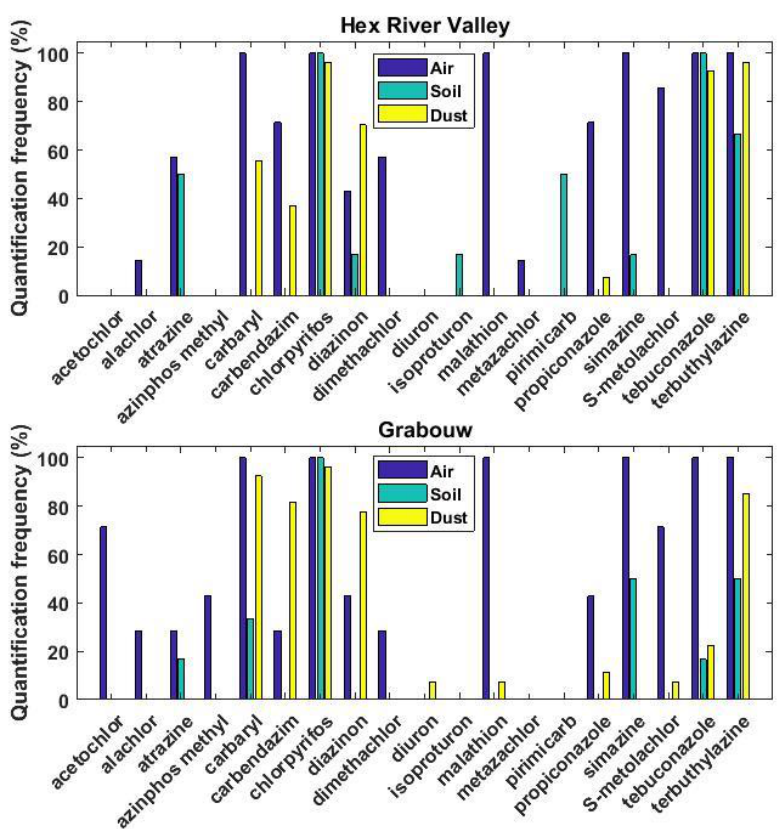
Figure 2. Quantification frequencies of the individual pesticides in air, soil, and dust. Data on pesticides in air and soil were obtained from [68]. Table 1. Summary of the concentrations (in ng g −1 ) of individual pesticides found in the dust samples collected in households. QF indicates quantification frequency in percentage, IQR indicates interquartile range. For propiconazole, S-metolachlor, diuron, and malathion, only the concentrations above the quantification limits were considered, while for the remaining pesticides, imputed data were considered for